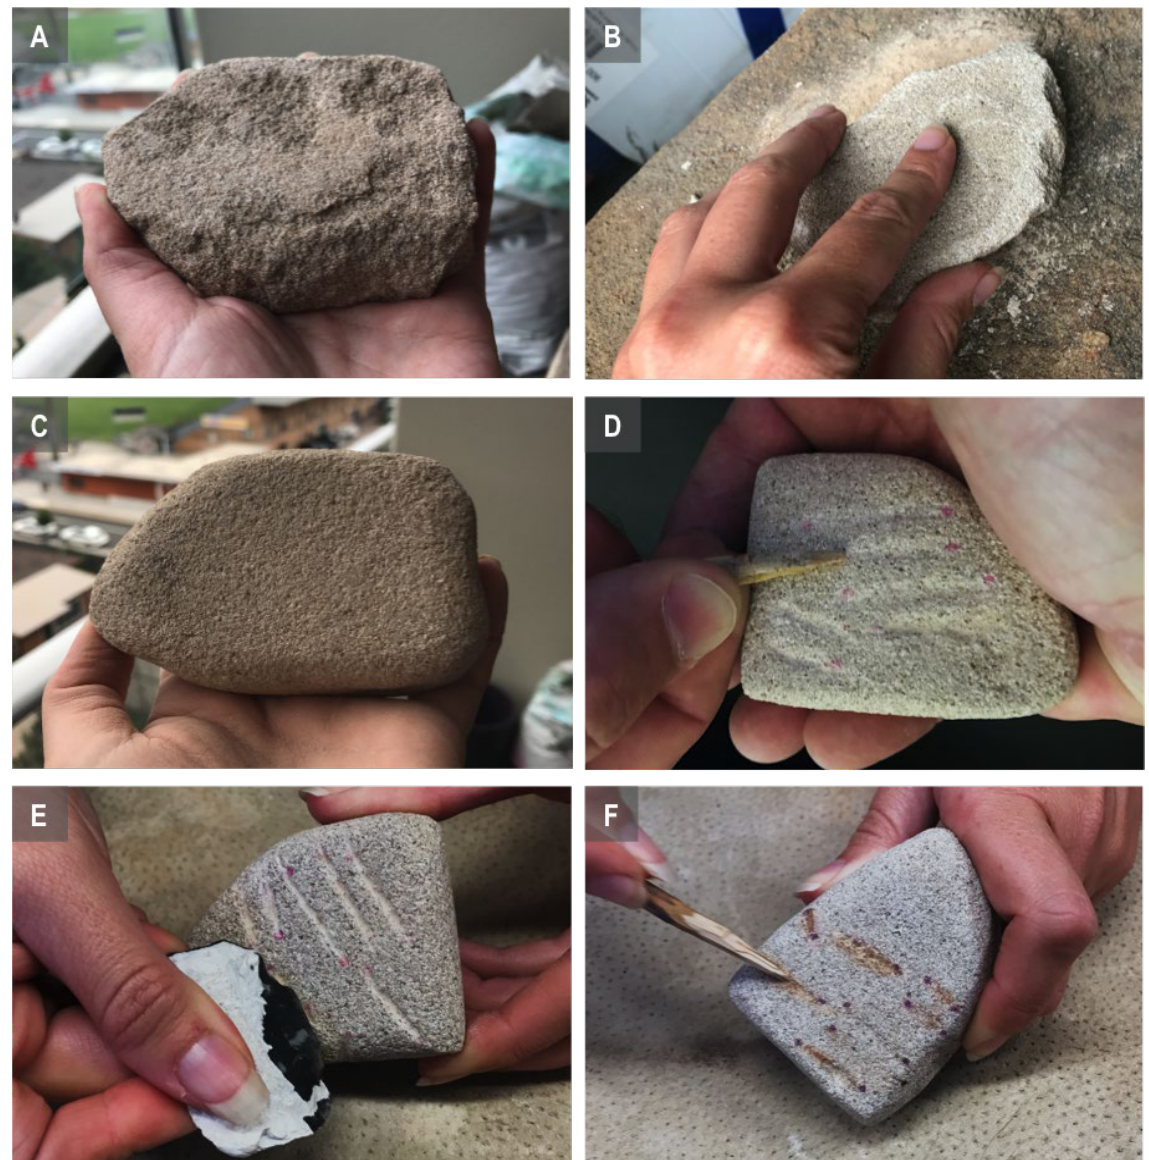
Figure 4. Making of the experimental sandstone replica tools: A) a weakly cemented, soft sandstone fragment shaped to resemble GS491; B) abrasively smoothing the surface of Experimental Tool 1 using a harder sandstone grinding slab; C) abrasively smoothed sandstone blank before incisions; D) Tool 1, Surface 1 grooves being created with a macropod fibula bone; E) Tool 1, Surface 2 grooves were made with the edge of an acute angled stone flake made from South Australian flint; F) Tool 2, Surface 2 grooves created using dry wood ( Eucalyptus leucoxylon